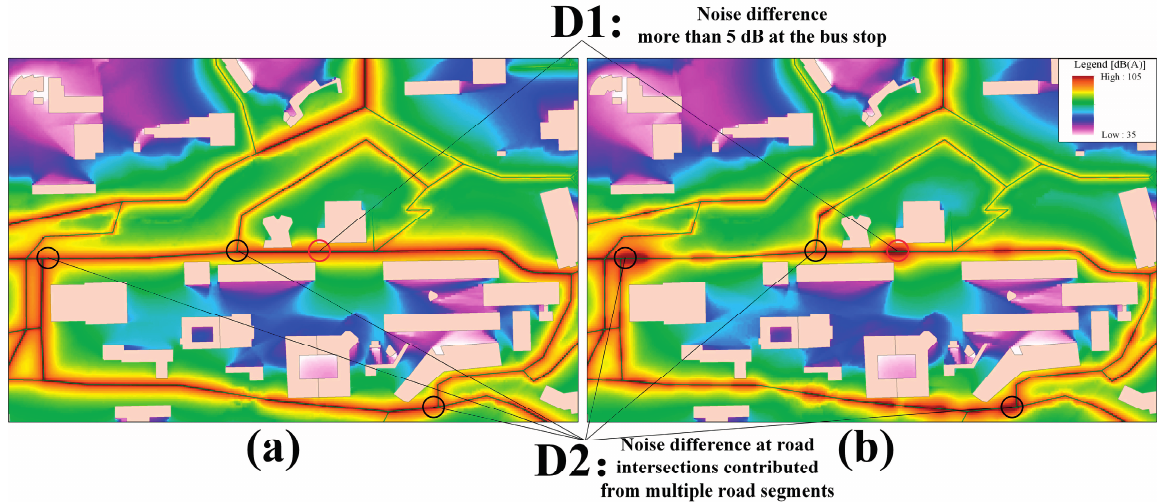
Figure 8. Noise simulation ( a ) based on average traffic volume and ( b ) based on the participatory noise data during a time period of one